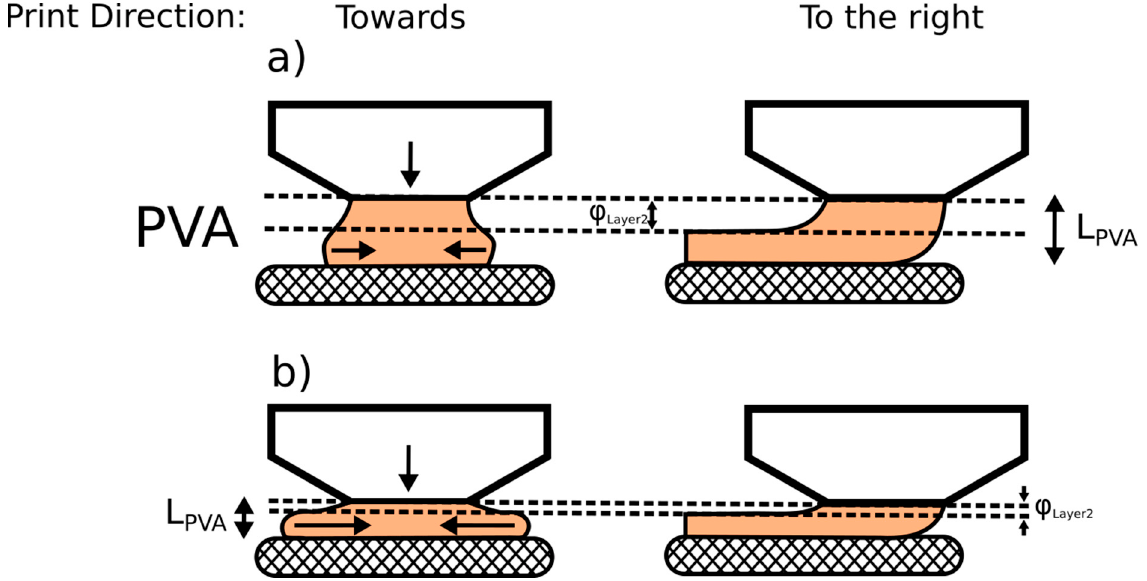
Figure 12. A pictorial representation of PVA deposition on a printer bed with a nozzle moving towards (Left) or to the right (Right) of the vantage point. The differences in the aspect ratio of the cross sections of the deposited polymer are shown for ( a ) larger and ( b ) smaller values of L PVA . The forces exerted by polymer deposition and contact with the print bed are marked by arrows shown.